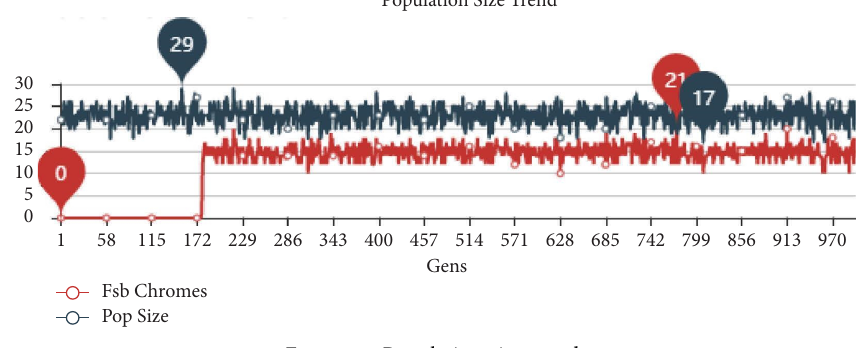
Figure 7: Population size